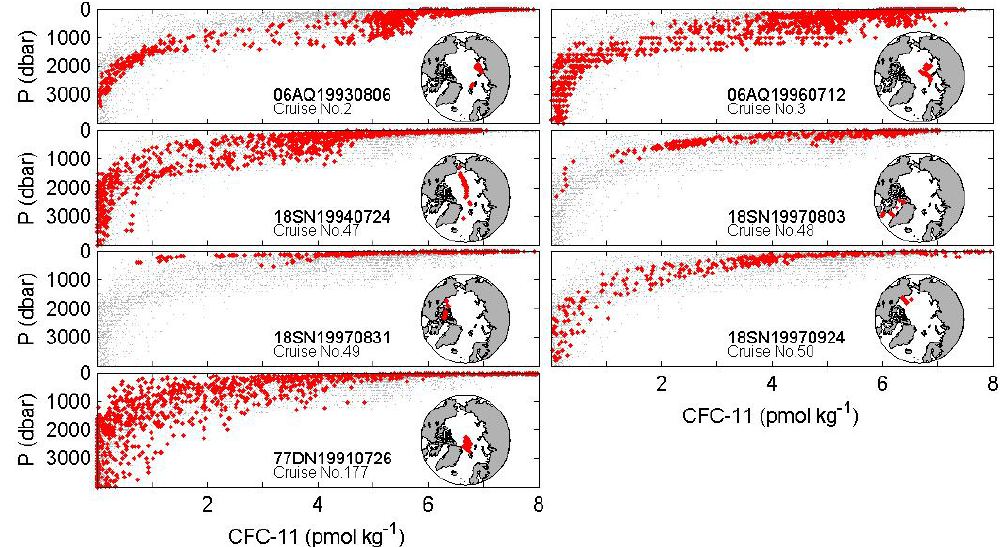
Figure 11. CFC-11 vs. pressure (dbar) for all Arctic Ocean cruises in CARINA. The red dots mark the data from each specific cruise, and the grey dots shows the CFC-11 data from all Arctic Ocean CARINA cruises. The inserted map shows the specific cruise track.